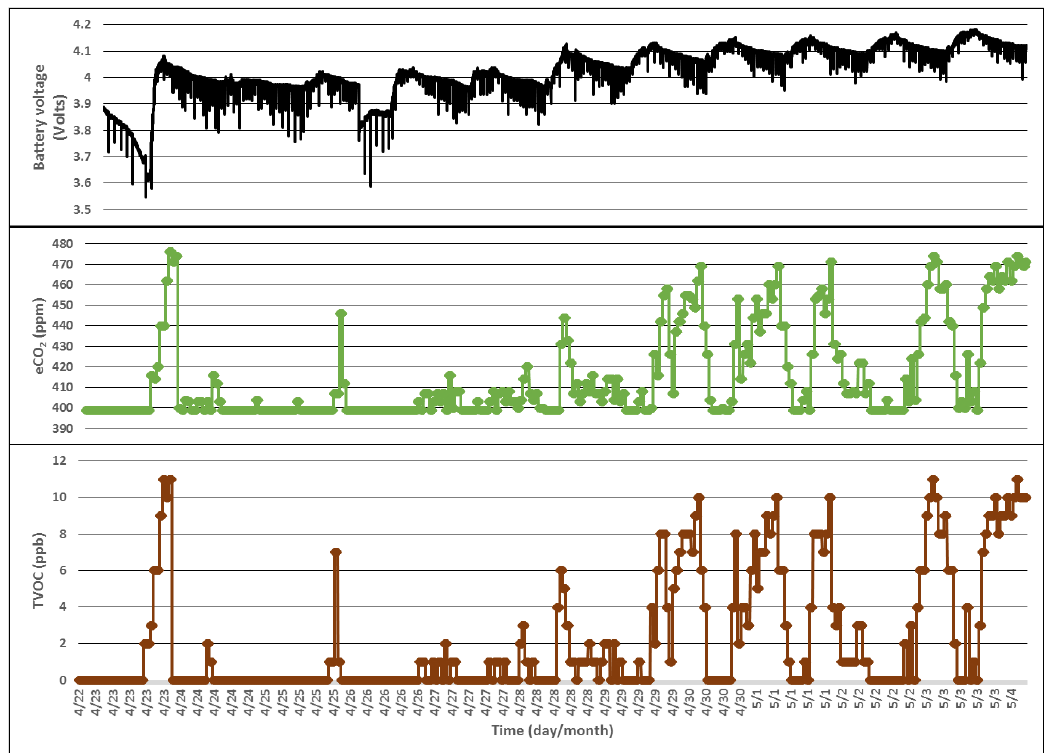
Figure 15. Energy budget and air quality parameters during 12